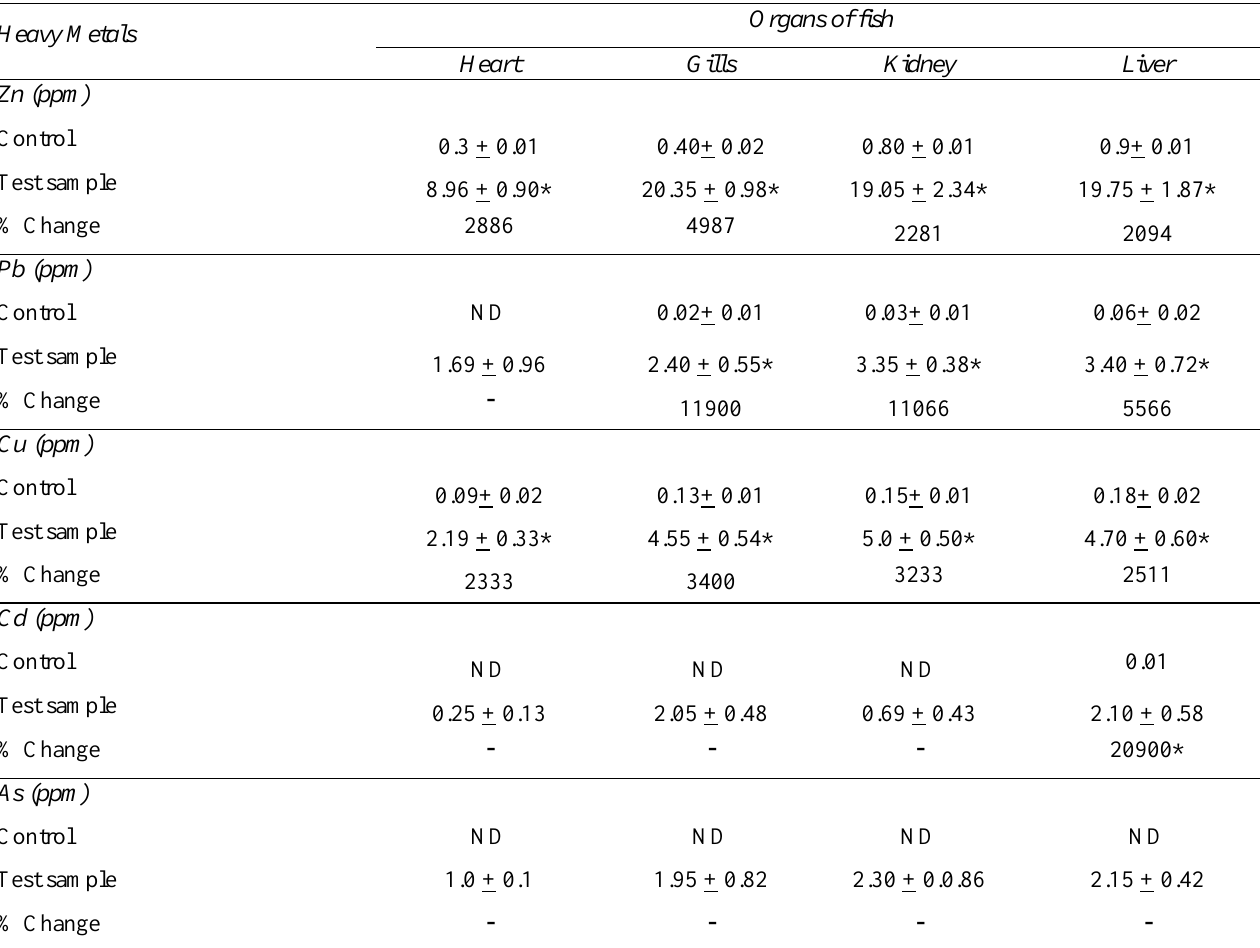
Table 1: The levels of heavy metals in the liver, kidney, gills and heart of Clarias gariepinus from the Ogun River (test sample) and Agodi River